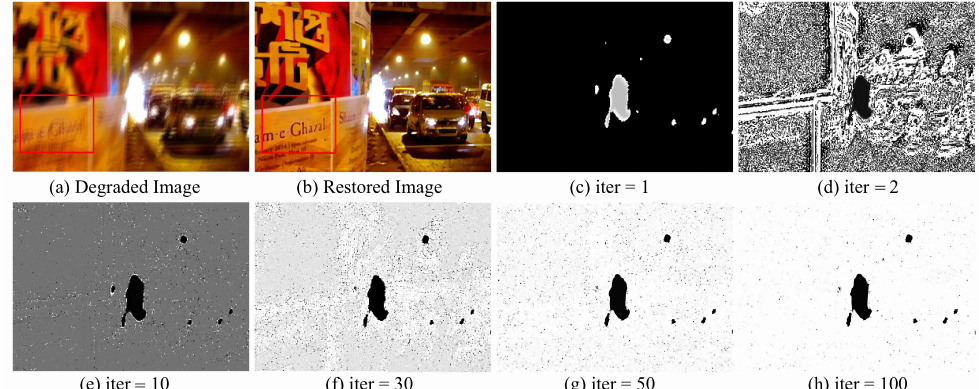
Figure 5. ( a ) The degraded image, ( b ) the restored image, and ( c – h ) variations of the weight W with